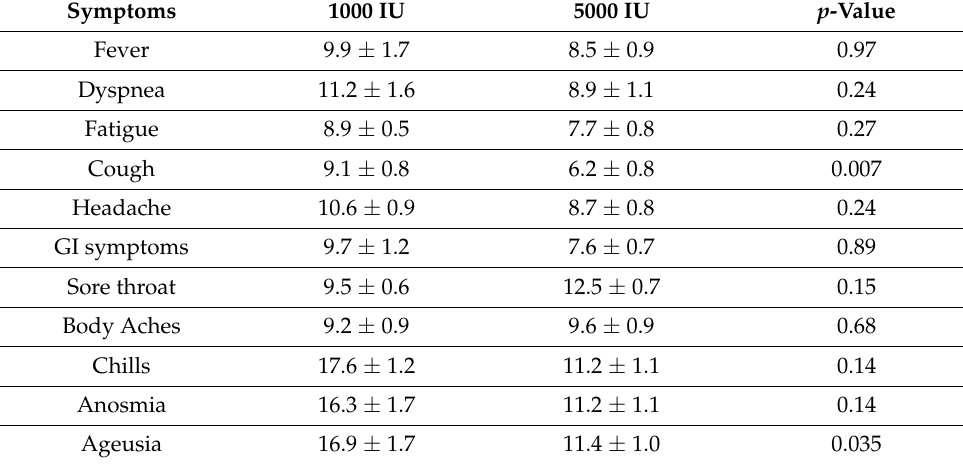
Table 2. Average Days to Resolve Covid-19 Symptoms according to Vitamin D Dose.